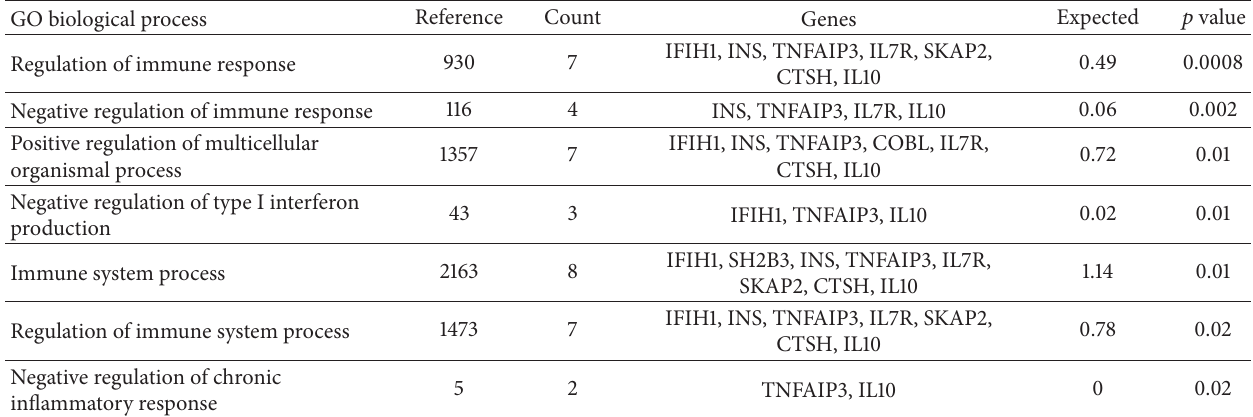
Table 3: The gene ontology terms of the 11 T1D candidate genes.